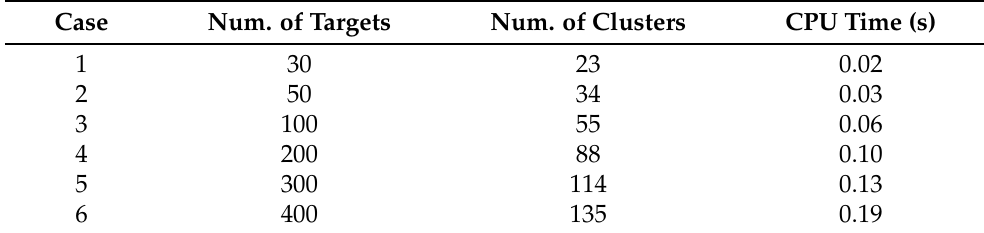
Table 3. Task clustering results with different numbers of